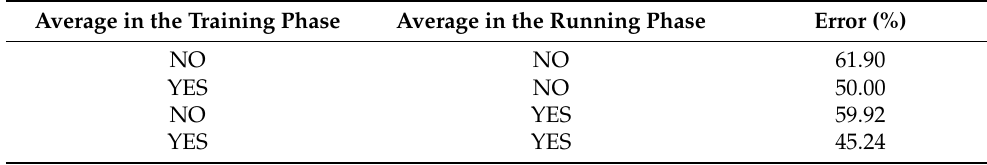
Table 3. SCI on video, test material. VISION dataset (smartphone videos); method: majority, N = 15. Average in the Training